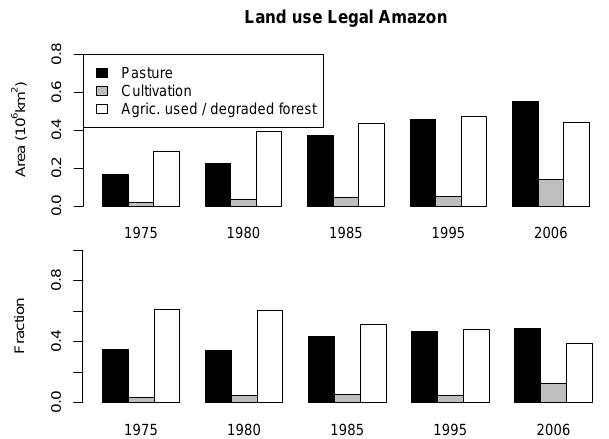
Fig. 3. (a) Agriculturally used land by area in the legal Amazon, and (b) fraction of agriculturally used area by each of the three land use practices (from IBGE, AGROPECUARIA 2006; http://www.ibge. gov.br/home/estatistica/economia/agropecuaria).